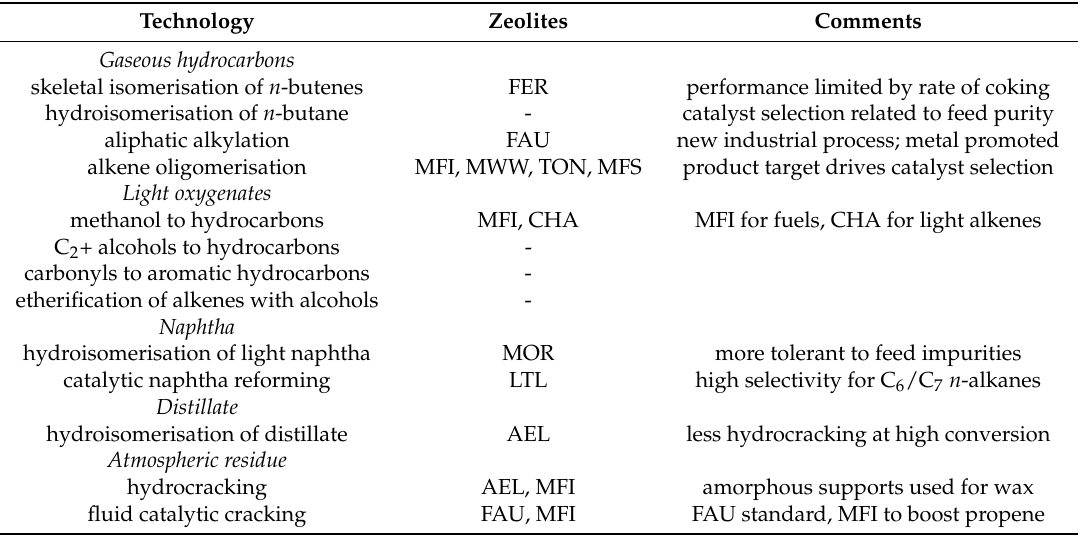
Table 4. Summary of the refining technologies relevant to indirect liquefaction where zeolite catalysts could be preferred